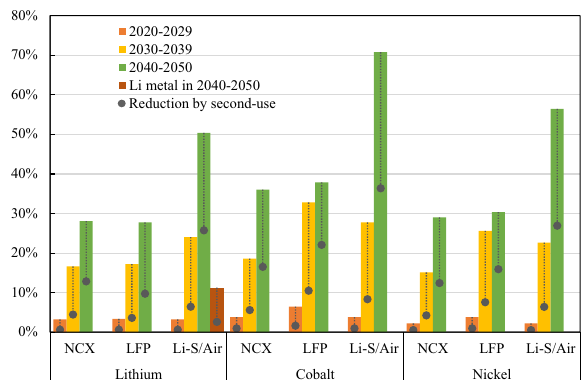
Fig. 6 Closed-loop recycling potential of battery materials in periods of Hydrometallurgical recycling is used for NCX and LFP batteries and mechanical recovery of Li metal for Li-S and Li-Air batteries. Gray dots show how second-use, which postpones the time of recycling, reduces the closed-loop recycling potentials and thus the availability of secondary materials in the coming decades. See Supplementary Table 8 for other